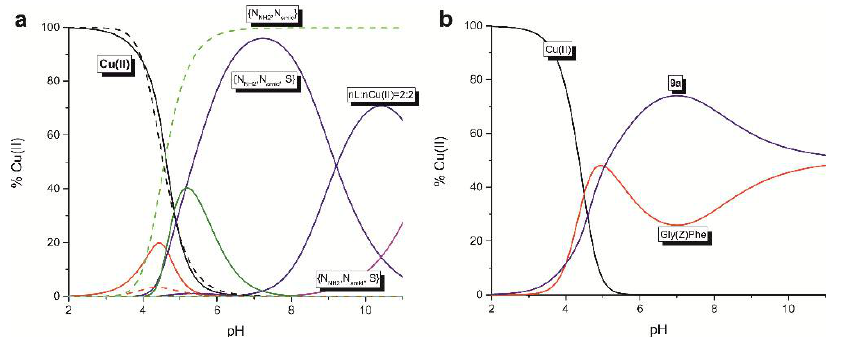
Figure 5. The comparison of: ( a ) formation of subsequent complexes for 9a (solid line) and Gly( Z )Phe (dashed line) in dependence on pH, ( b ) efficiency in copper(II) binding for the n L :n Cu(II) = 1:1 molar